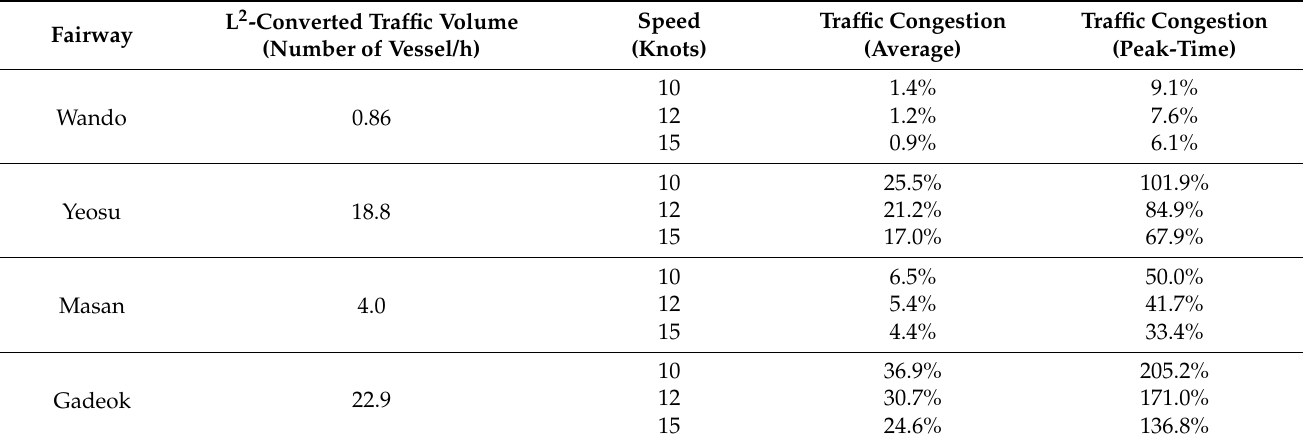
Table 6. Average Hourly Congestion and Peak-Time